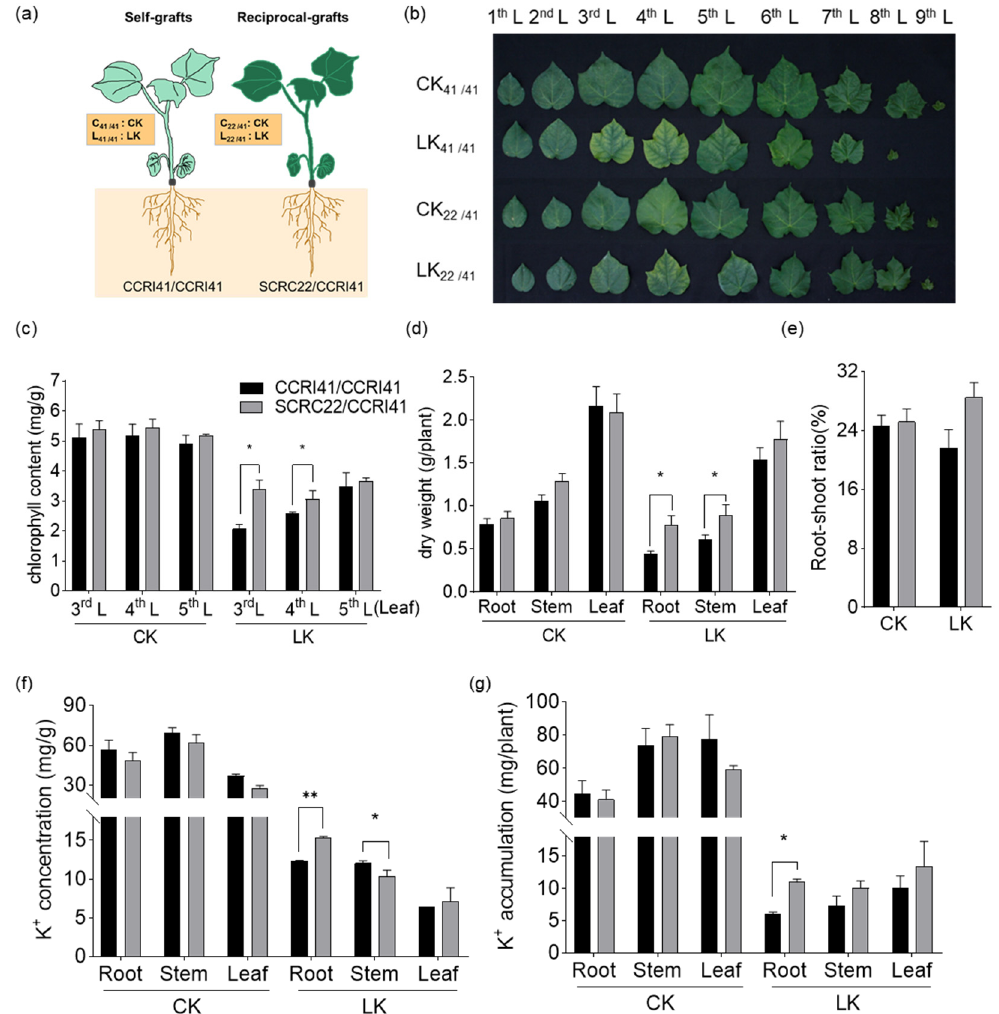
Figure 1. Effects of potassium (K + ) deficiency on CCRI41 (a K + inefficient cotton variety) self-grafts (CCRI41/CCRI41, scion/rootstock) and its reciprocal grafts (SCRC22/CCRI41) with SCRC22 (a K + efficient variety). Grafting was performed hypocotyl-to-hypocotyl ( a ) when the cotyledons of rootstock just fully expanded. Grafts were subjected to low K + (LK, 0.03 mM K + ) at the three-leaf stage, with 2.5 mM K + as control (CK). After 16 days, all leaves were photographed ( b ), and the chlorophyll content in the third (3rd L), fourth (4th L) and fifth (5th L) leaves was measured ( c ). The dry weight of roots, stem and leaves was recorded ( d ), and the root-shoot ratio was calculated ( e ). K + concentration ( f ) and K + accumulation ( g ) in roots, stem and leaves were determined or calculated. CK: Control; LK: Low K + treatment. The data are shown as means ± SD of three replicates ( n = 3); * and ** indicate significant differences at 5% and 1% level, respectively.